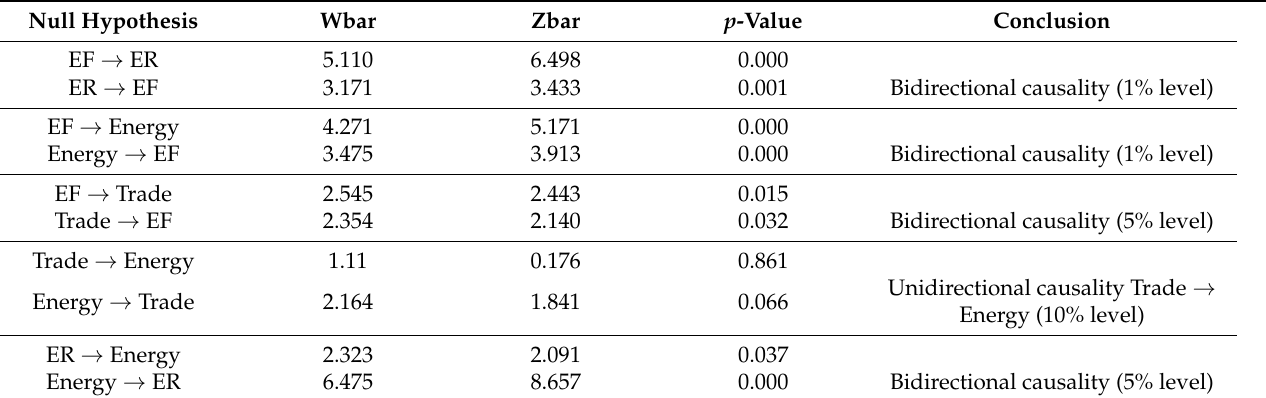
Table 8. Dumitrescu-Hurlin Causality Test